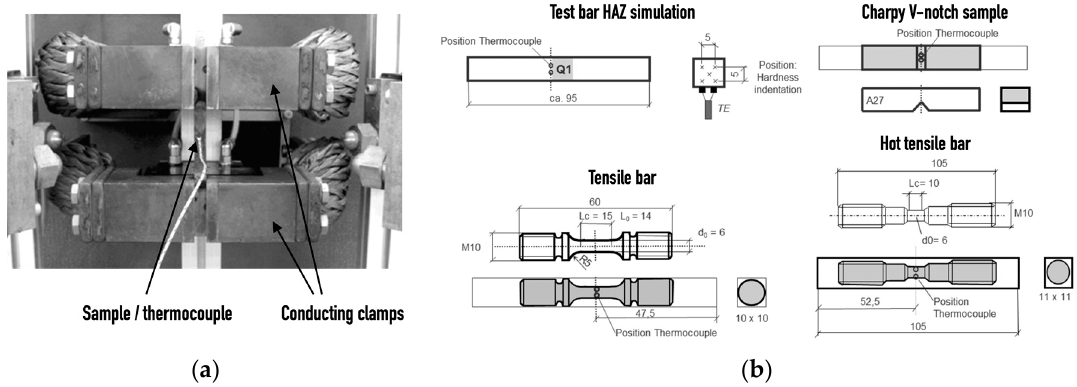
Figure 4. (a) Setup for HAZ simulation and (b) sample geometries for mechanical testing. HAZ simulations were performed for the inter-critical zone (ICZ), i.e., the peak temperature being in the ferrite-austenite two-phase region, and for the coarse-grained zone (CGZ) using a peak